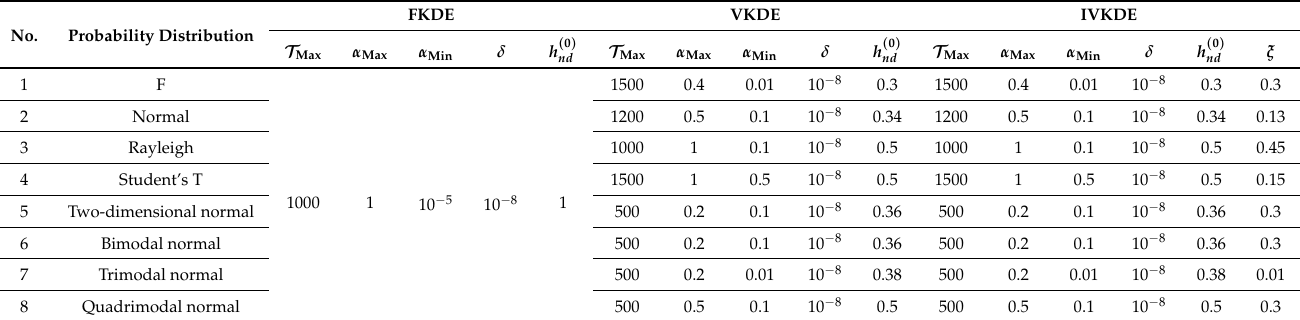
Table 2. Parameter settings of FKDE, VKDE, and